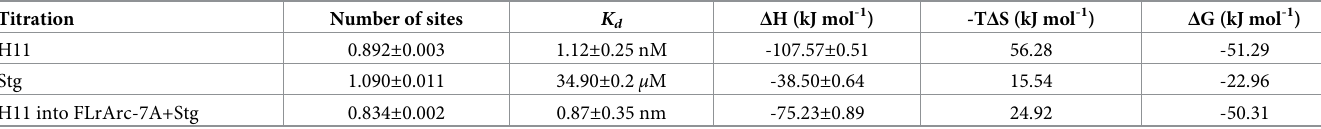
Table 3. ITC displacement assay to follow H11 and Stg binding to FLrArc-7A. The thermodynamic parameters of binding were obtained from the titration curves in Fig 8C. Error margins indicate errors of data fitting from single experiments.